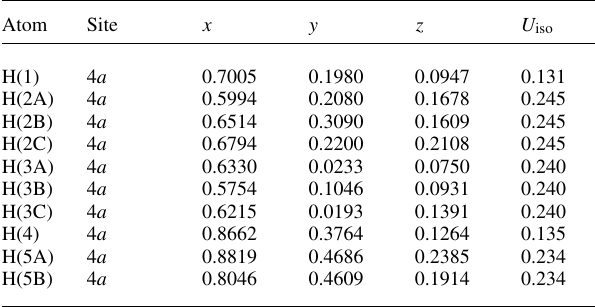
Table 2. Atomic coordinates and displacement parameters (in Å 2 )